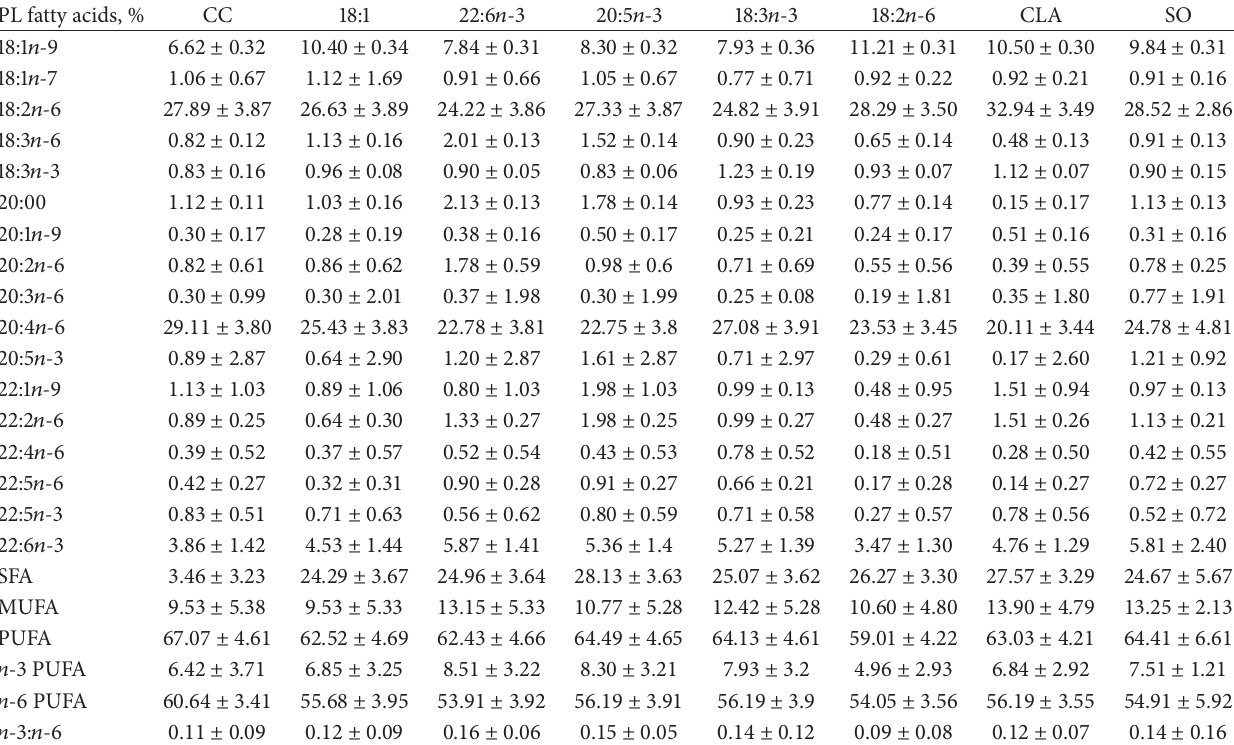
Table 2: Changes of plasma phospholipids fatty acids in rats after